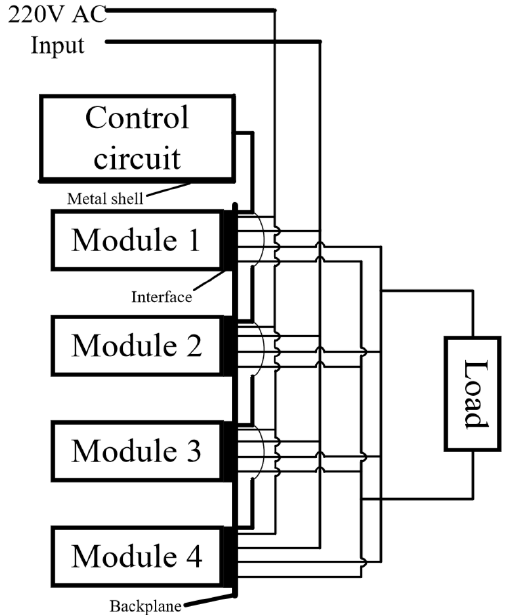
Figure 3. Power supply block